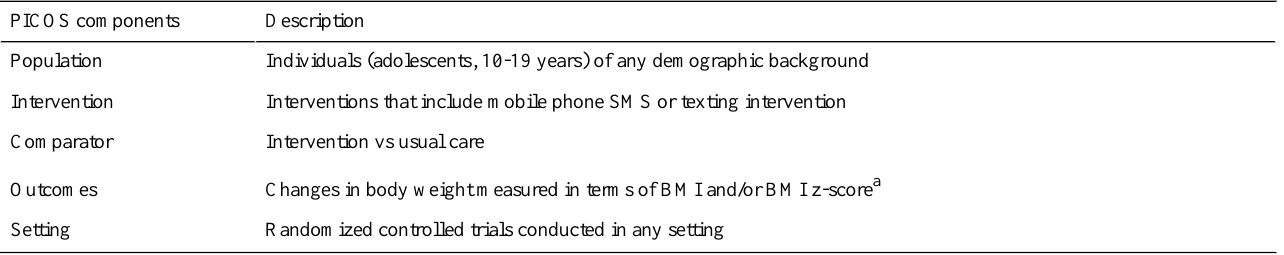
Table 1. Summary description of Population, Intervention, Comparator, Outcomes, and Setting (PICOS) components. DescriptionPICOS